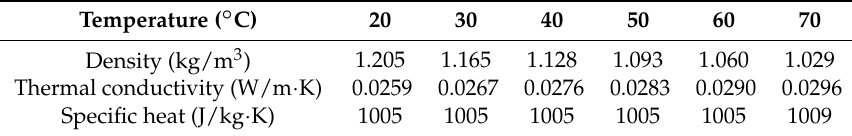
Table 2. Thermo-physical properties of air under different temperatures.